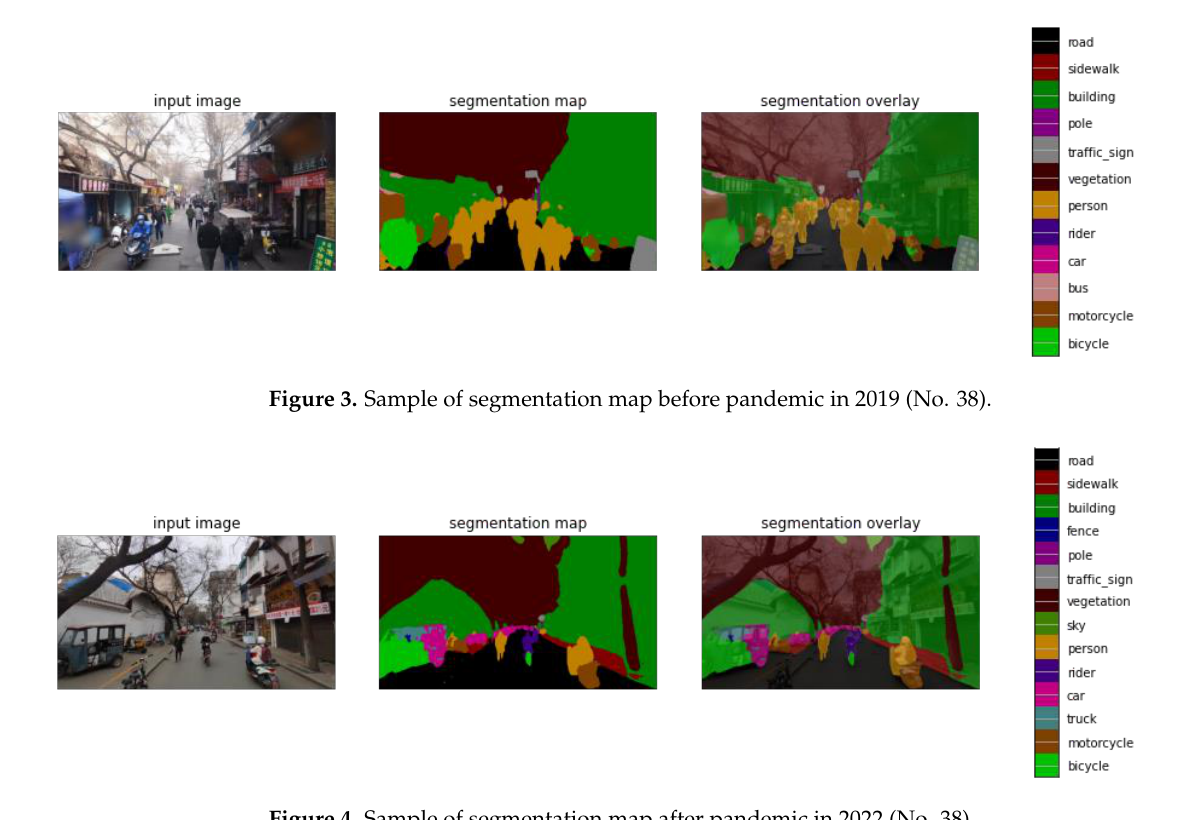
Figure 4. Sample of segmentation map after pandemic in 2022 (No. 38).